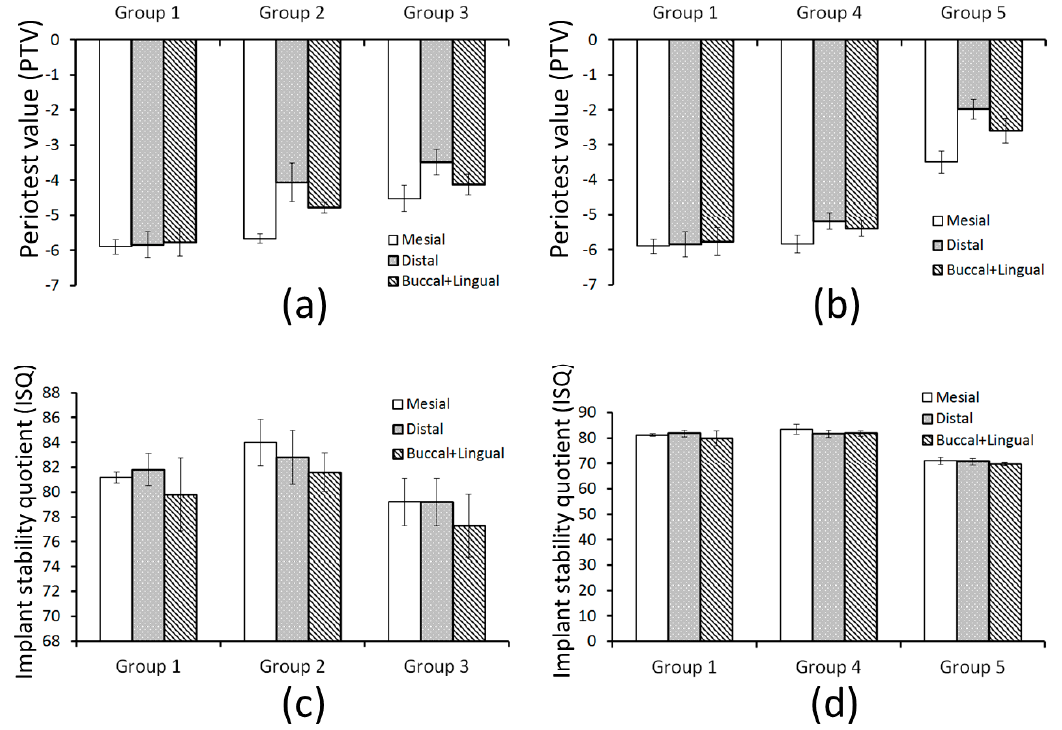
Figure 5. PTV ( a , b ) and ISQ ( c , d ) measurements of Groups 1, 2 and 3 and Groups 1, 4 and 5.